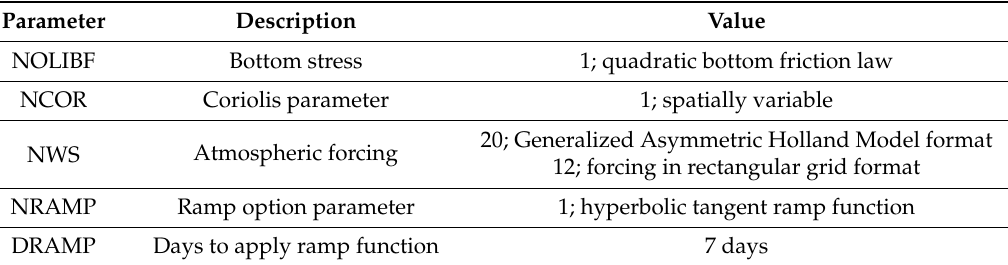
Figure 1. ( a ) Advanced Circulation Model (ADCIRC) finite element unstructured mesh used for the Federal Emergency Management Agency (FEMA) Region II Coastal Surge Study [36]. The mesh has been designed with higher resolution along the Hudson Bay, NJ, and NY coastal regions. The mesh has 604,790 nodes; ( b ) Zoom in for the white box in ( a ) of the NJ and NY coastline. Raritan Bay, Delaware Bay and Long Island Sound bays are identified. Table 2. ADCIRC model configuration parameters.